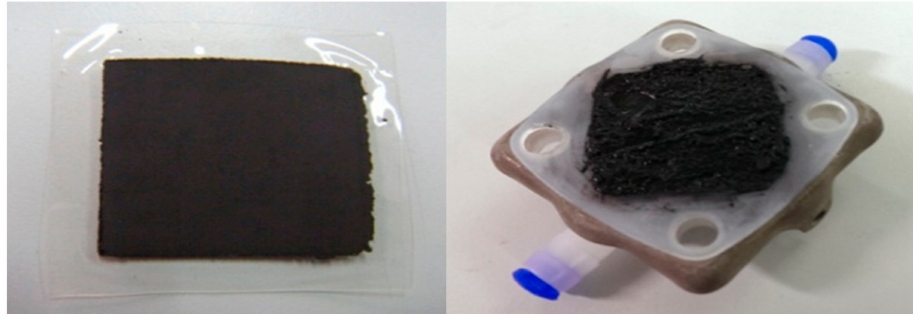
Figure 1. Anode side of ( a ) membrane-layer (ML) (left) and ( b ) flat-layer (FL) (right)